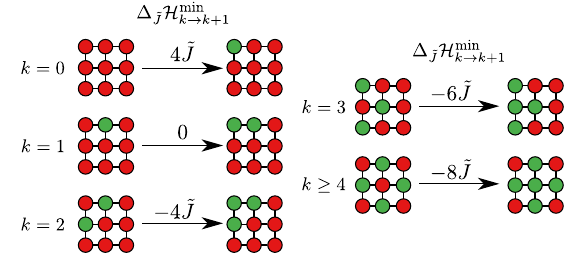
FIG. 15. Minimum energy forward transitions between σ 0 k and two configurations f σ and f σ with N j g j g c ðf j gÞ ¼ i σ 0 N Þ ¼ k þ 1 , respectively. Although we depict here the c ðf j g i minimal energy differences for a lattice of size N ¼ 3 × 3 , the result holds for any two-dimensional lattice of size N ≥ 3 × 3 as long as the transitions for k ¼ 0 , 1, 2 are taken at the corner, and the transition for k ¼ 3 is taken at the